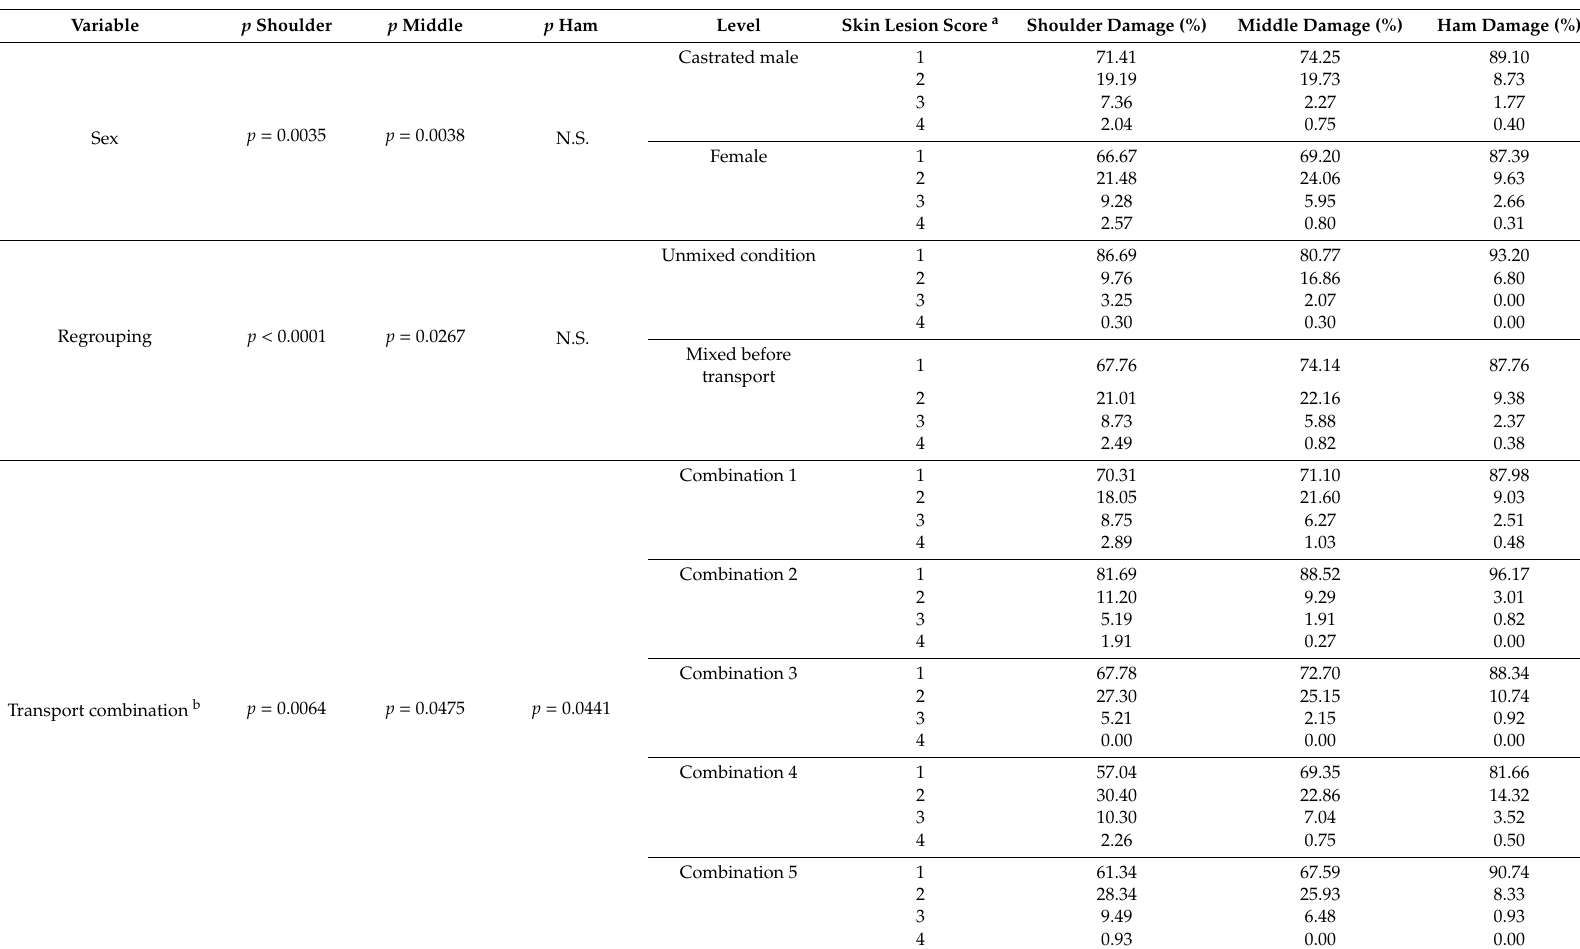
Table 5. Frequencies ( n = 4507) of the e ff ect of sex, regrouping, transport combination, and transport compartment on skin damage. The dependent variables are shoulder, middle, and ham damage. Shown p -values are per carcass part (shoulder, middle and ham). Variable p Shoulder p Middle p Ham Level Skin Lesion Score a Shoulder Damage (%) Middle Damage (%) Ham Damage (%)